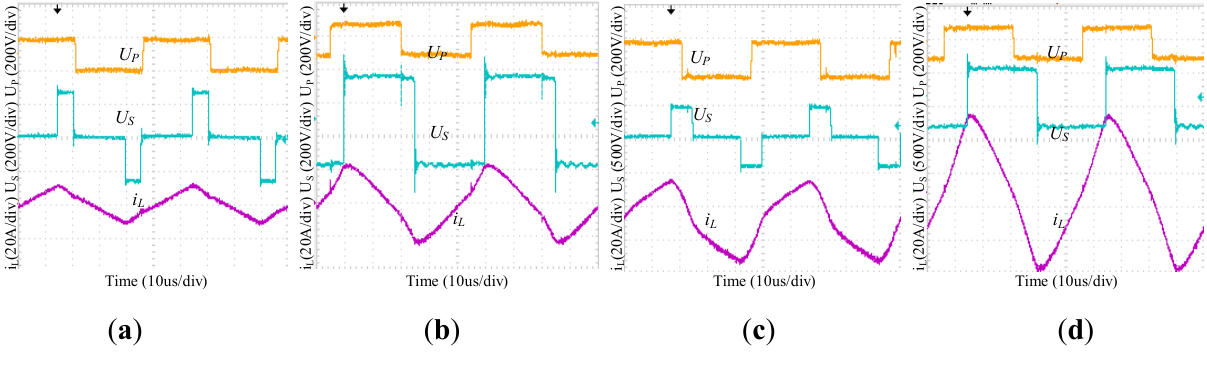
= 100 V, U = 250 V; ( b ) CSPS control 1 2 = 100 V, U = 500 V; ( d ) CSPS 1 2